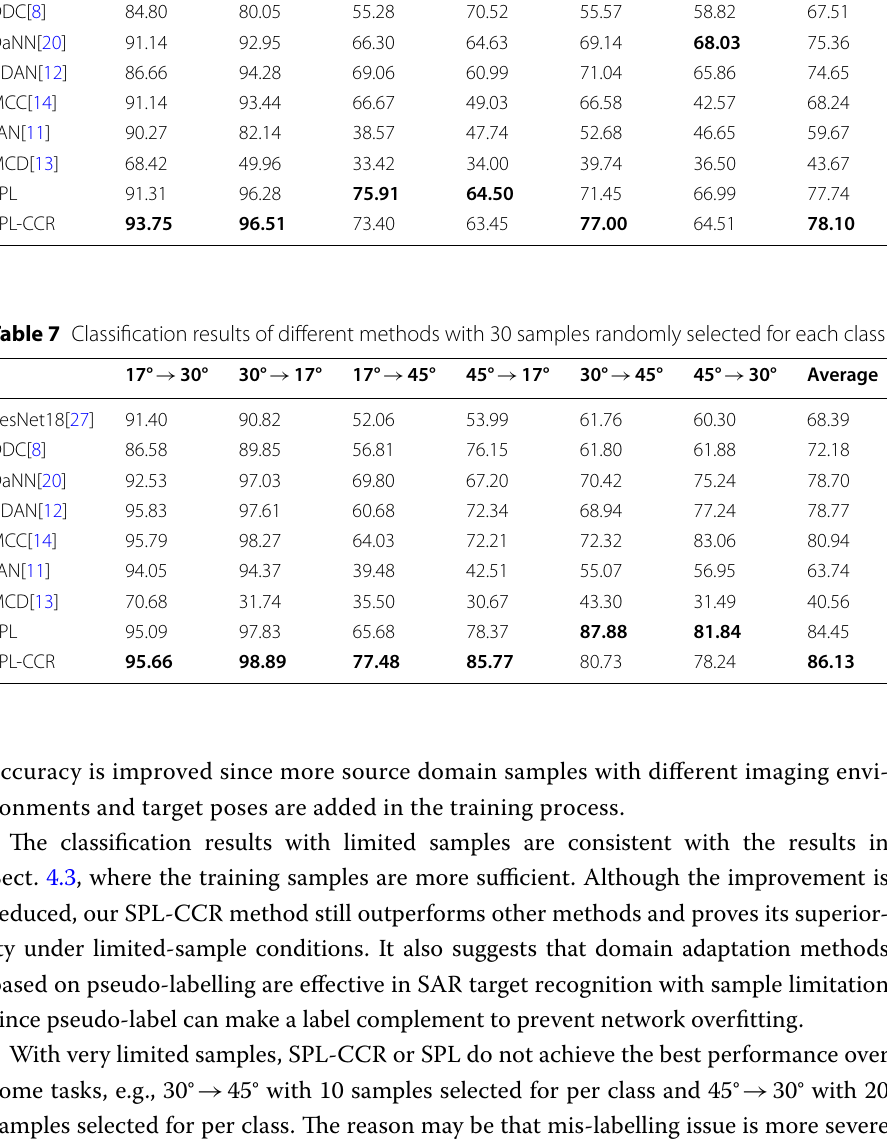
Table 6 Classification results of different methods with 20 samples randomly selected for each class 17° 30° →